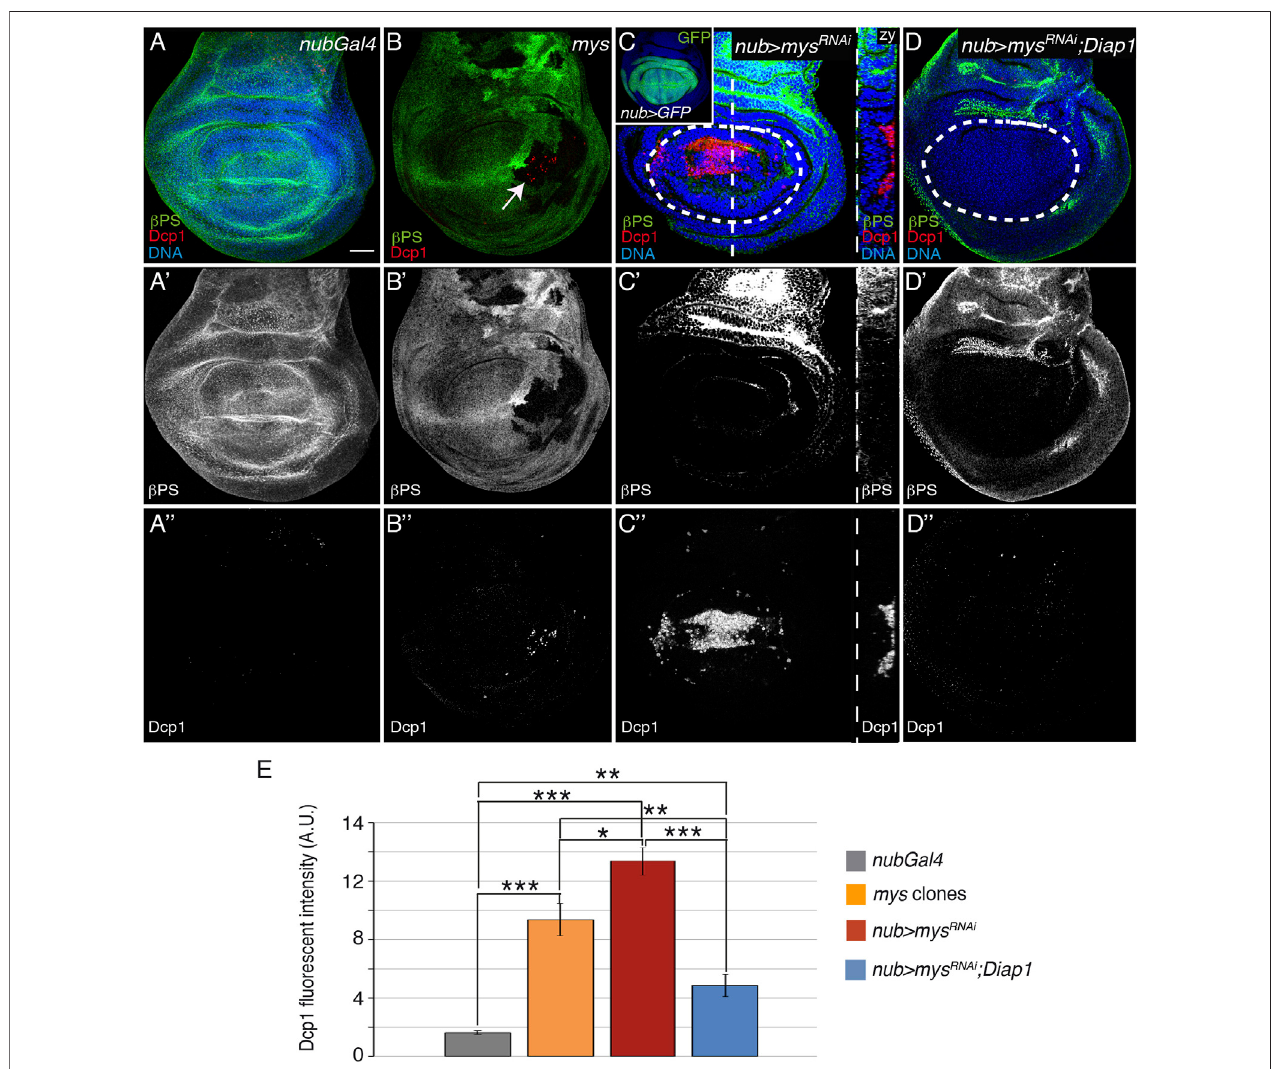
FIGURE 1 | Integrins promote cell survival in the wing imaginal disc. (A – D 99 ) Maximal projection of confocal views of wing imaginal discs from third-instar larvae stained with anti- β PS [green in (A – D) , white in (A 9 – D 9 )] , anti-Dcp1 [red in (A – D) , white in (A 99 – D 99 )] and the nuclear marker Hoechst [DNA, blue in (A – D) ]. (A) Control nubGal4 wing disc. (B) Wing disc carrying mys mutant clones (white arrow), marked by the absence of β PS (green). (C) Wing disc expressing GFP or a mys RNAiunder the control of nubGal4 , nub > GFP (inset) and nub > mys RNAi , respectively. (yz) Confocal yz section along the white dotted line shown in (C) . (D) Wing disc co- expressinga mys RNAi andDiap-1underthecontrolof nubGal4 , nub > mys RNAi ; Diap1 . (E) Quanti fi cation ofDcp1 levelsinwingdiscsofthedesignatedgenotypes. The dotted white circles indicate the wing pouch area in all fi gures. The statistical signi fi cance of differences was assessed with a t -test, ***, ** and * p values < 0.001, < 0.01, and < 0.05, respectively. Scale bar in all panels, 30 μ